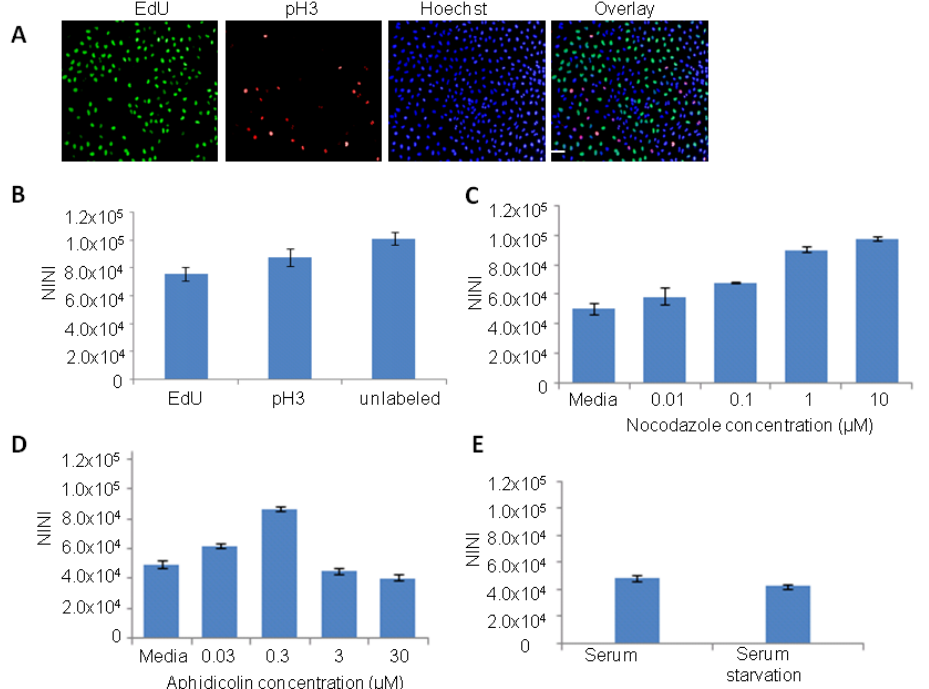
Figure 1. Cell cycle analysis using high-content imaging. ( A ) Representative images of HeLa cells stained with EdU (marker of S phase), pH3 (a marker of M phase) and Hoechst 33342 (marker of DNA). ( B ) Bar graph showing the population of cells in different phases of cell cycle based on normalized integrated nuclear intensity (NINI) derived from the DNA binding dye (Hoechst 33342). NINI value is calculated by measuring the integrated nuclear intensity divided by the number of nuclei within each well. The NINI values derived from mitotic nuclei (pH3 labeled) indicate 4N DNA content, while NINI values for S phase (EdU marked nuclei) range between 0.5 and 1X NINI values of pH3 (2N to 4N DNA content). ( C , D ) HeLa cells were treated with indicated concentrations of nocodazole ( C ) or aphidicolin ( D ) for 12 h and then fixed and stained with Hoechst 33342 dye. Cells were imaged and analyzed to extract and calculate the NINI values. ( C ) A dose-dependent increase in NINI values, which corresponds 4N DNA content and a block in G2/M phase was observed with nocodazole. ( D ) Treatment with low aphidicolin concentrations (0.03 and 0.3 µ M) results in increasing NINI values which corresponds to a block in G2/M phase, while high aphidicolin concentrations (3 and 30 µ M) results in NINI values that correspond to G1 phase. ( E ) HeLa cells were serum starved for 24 h, then fixed and stained with Hoechst 33342 dye. Images were analyzed to extract the NINI values. Serums starved cells showed reduced NINI values compared to control cells incubated with complete medium. Scale bar, 20